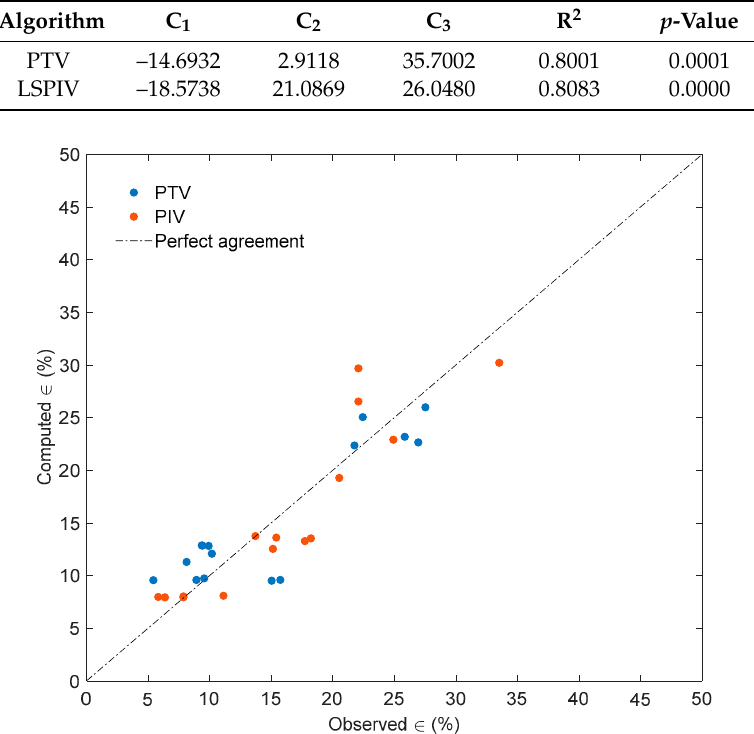
Figure 12. Error predicted by multiple regression analysis vs. error observed with PTV and LSPIV.